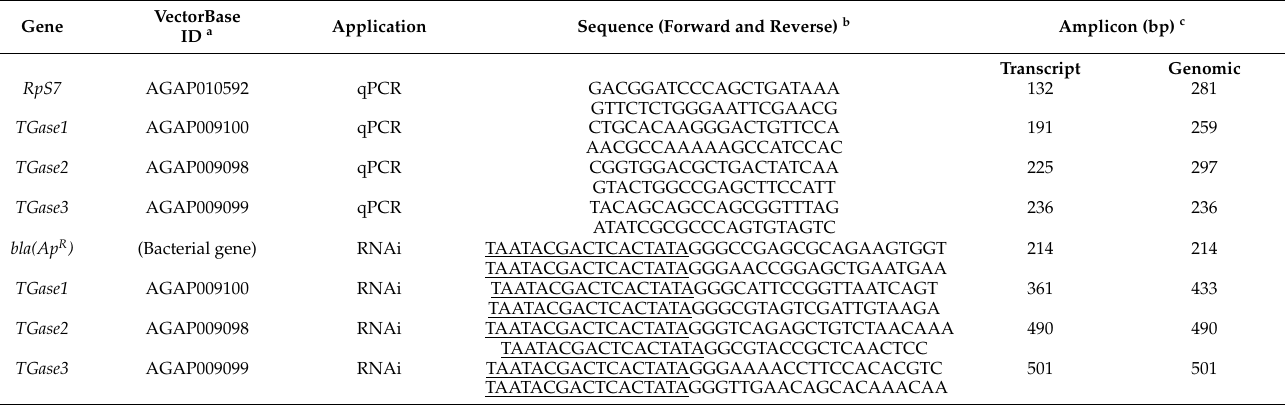
Table 1. Gene names, gene IDs, and primers used in this